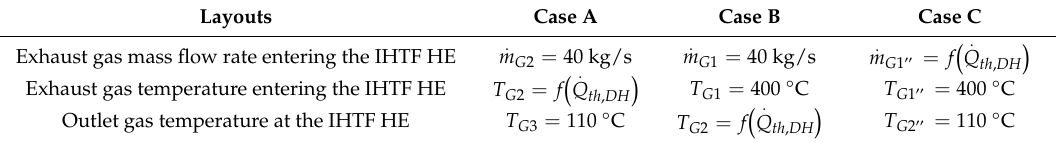
Table 1. Constants and variable parameters for each proposed layout.